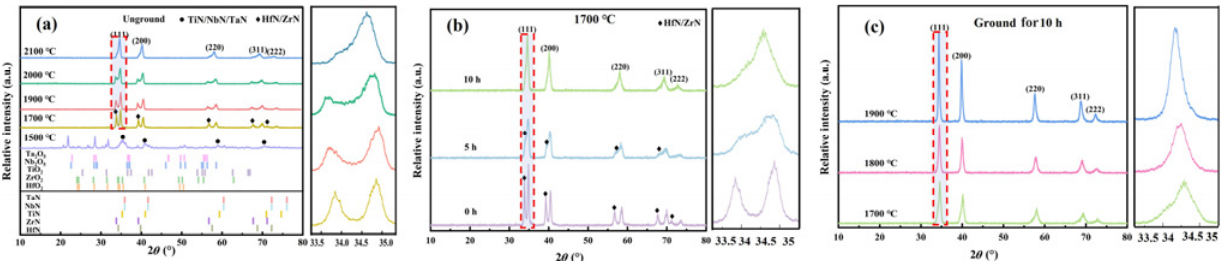
Fig. 2 XRD patterns of (HfZrTiNbTa)N powders obtained from (a) raw material mixtures unground and subsequently sintered at different temperatures; (b) raw material mixtures ground for different time and subsequently sintered at 1700 ; and (c) raw ℃ material mixtures ground for 10 h and subsequently sintered at different